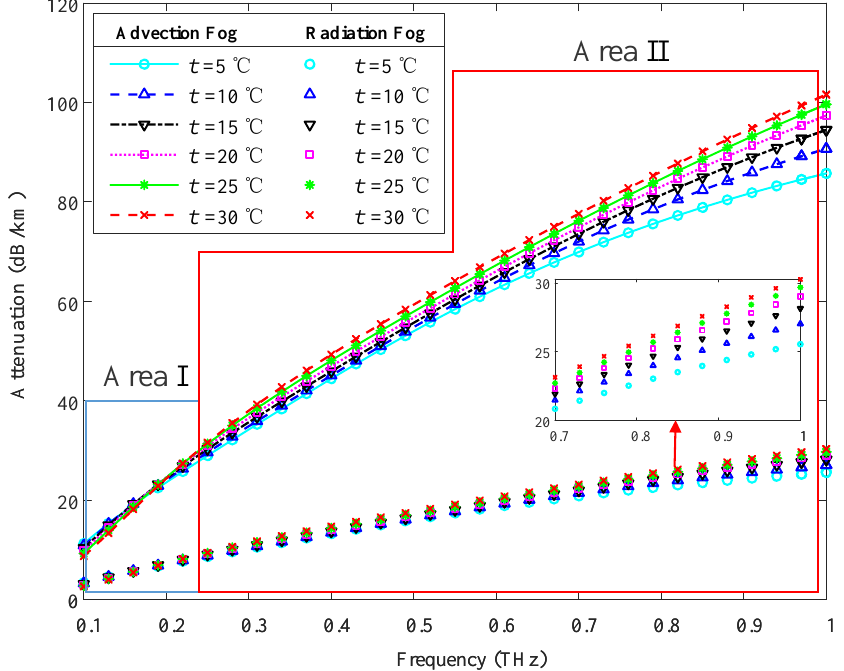
Figure 3. Fog attenuation of terahertz waves at diverse temperatures, where area I is the frequency range of 0.1–0.24 THz, and area II is the range of 0.24–1